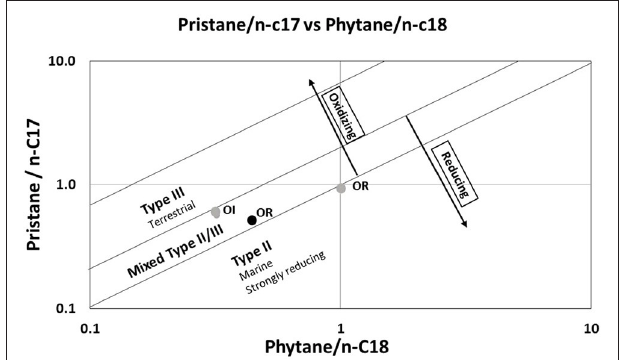
FIGURE 8 | Pristane n- 17 vs. Phytane/ n- 18 plots for WV6 (gray circle) and WV 7(black circles) samples. OR represents organic rich sample, OI represents organic intermediate